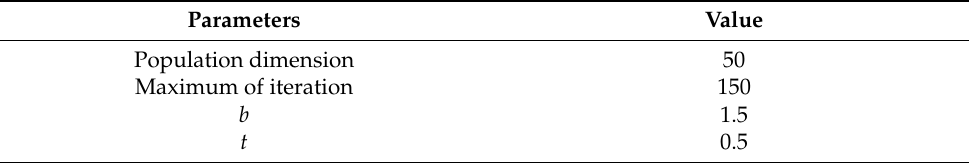
Table 2. Moth-flame optimization algorithm implementation